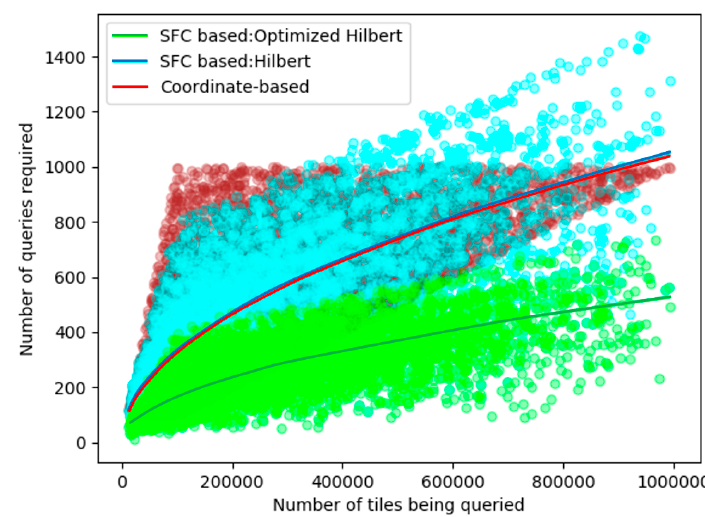
Figure 12. Number of queries required to cover the queried region of 3 method out of a 11-order quad-tree map.